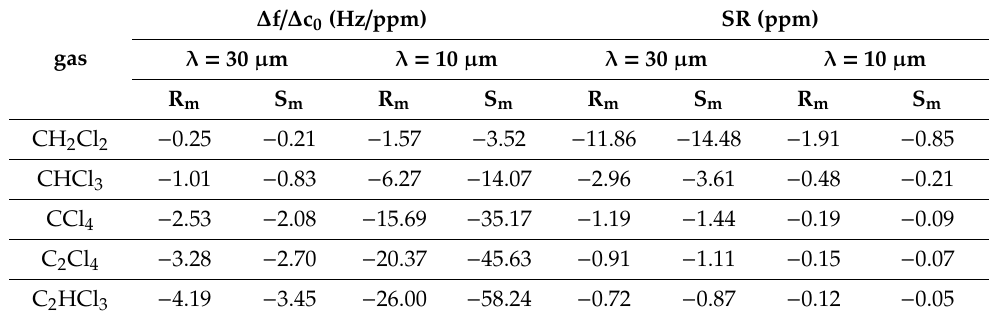
Table 1. The frequency shift ∆ f per unit gas concentration and the SR of the four SAW modes for di ff erent gases, at a fixed PIB layer thickness (0.8 µ